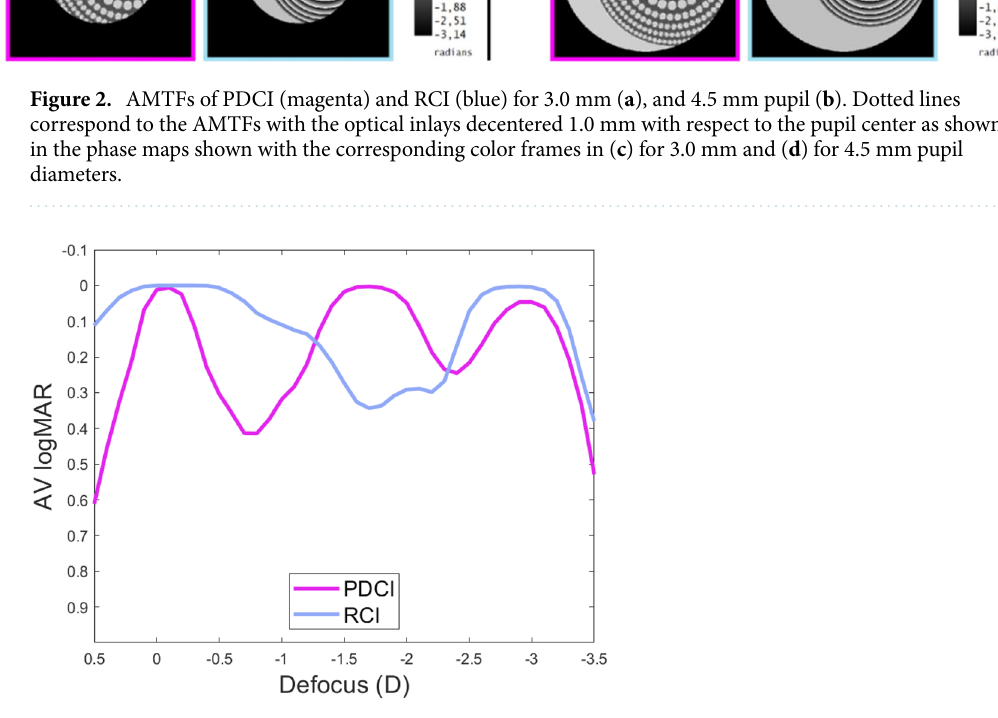
Figure 3. Through-focus VA curves for the PDCI (magenta), and RCI (blue) obtained from the AMTFs using Eq. (1). The pupil size is 4.5 mm and the abscissa axis has the origin (0.0 D defocus) at the distance focus of each